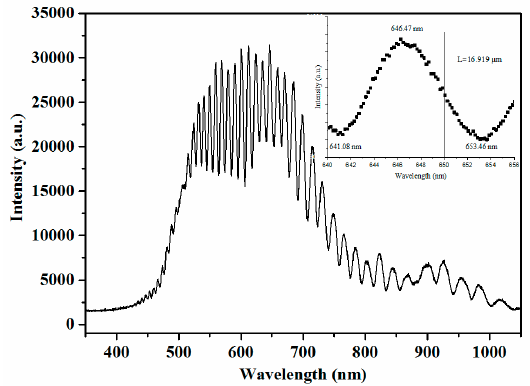
Figure 4. Interference spectrum measured for determining the cavity length. 174